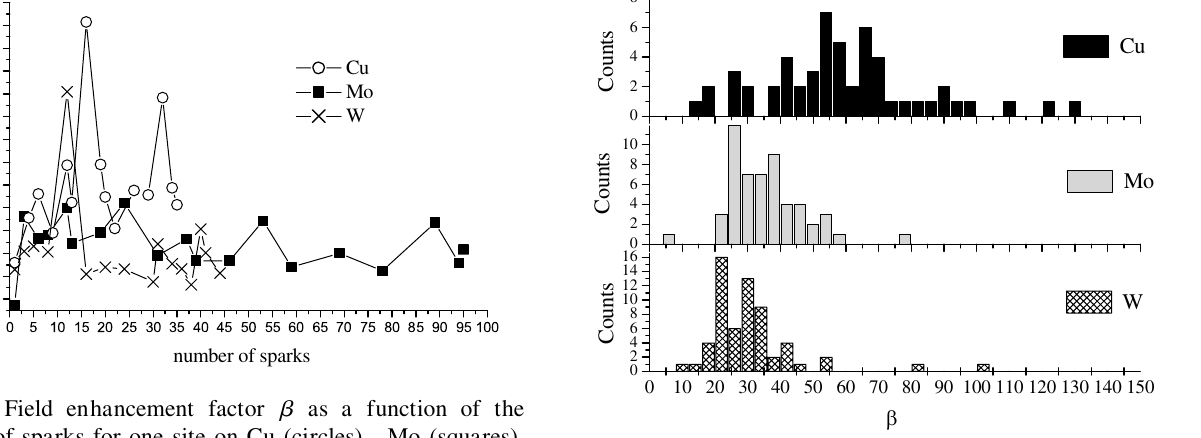
i ), average field enhancement factor ( h (cid:1) i b 1 G